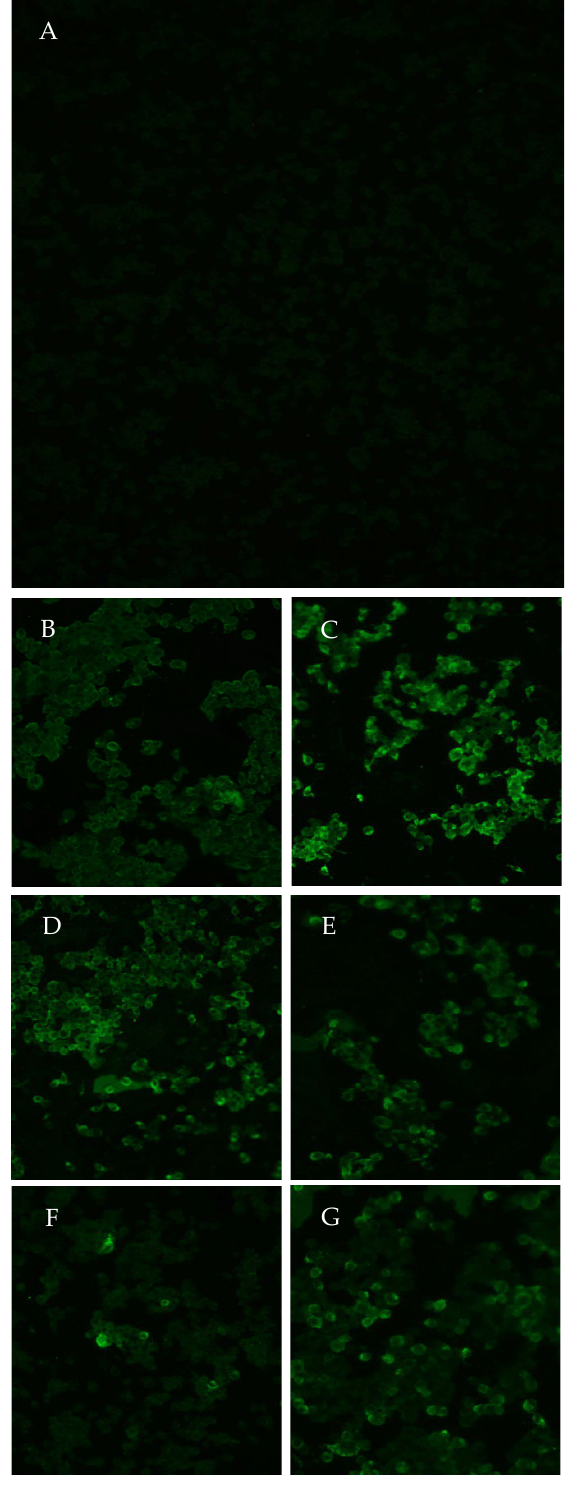
Figure 3. Indirect immunofluorescence using monoclonal antibodies specific for YFV in C6/36 cell cultures: ( A ) negative control; ( B ) positive head sample (2AALC) analyzed at 14 dpi; ( C ) positive head batch sample (3AALC) analyzed at 21 dpi; ( D ) positive thorax/abdomen batch sample (2AALT) analyzed at 14 dpi; ( E ) positive thorax/abdomen batch sample (3AALT) analyzed at 21 dpi; ( F ) positive leg batch sample (2ALP) analyzed at 14 dpi; ( G ) positive leg batch sample (3AALP) analyzed at 21 dpi. The magnification is 40×.